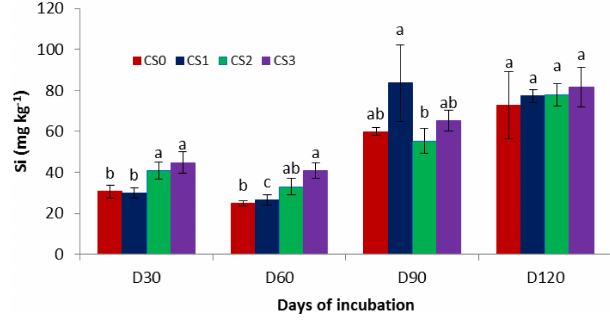
Figure 3. Effects of calcium silicate application on exchangeable calcium. Means marked with the same letter for each incubation day are not significantly different at p< 0 . 05 (Tukey‘s test).